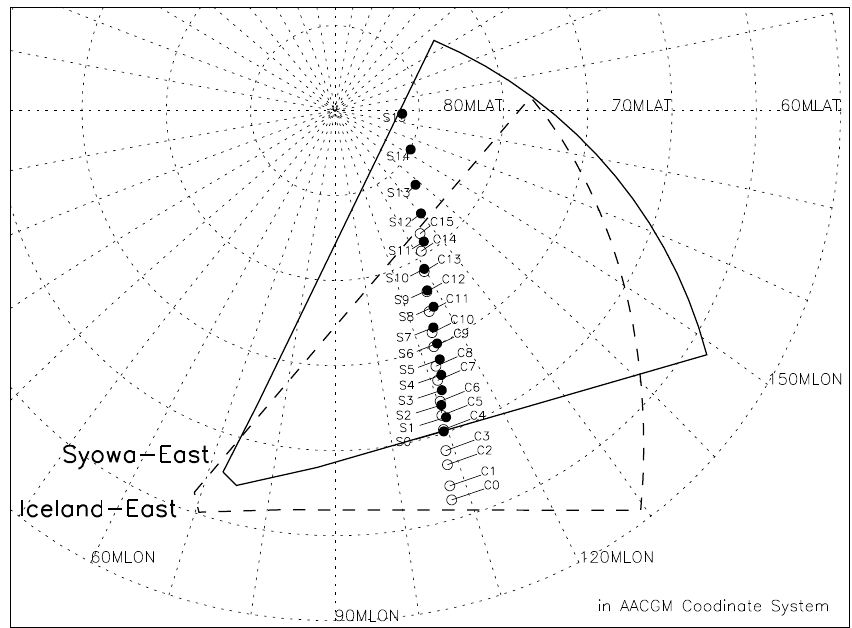
Fig. 1. The location of the summary point arrays within the field-of-view of CUTLASS Iceland-East and SENSU Syowa-East radars which are mapped into the AACGM coordinate system in the Northern Hemisphere. The solid fan-shaped area indicates the field-of-view of Syowa- East and dashed indicates that of Iceland-East. The summary points and the field-of-view of Syowa-East radar are mapped into the Northern Hemisphere using the IGRF95 model. Open circles indicate the summary points of Iceland-East from C0 to C15 and filled circles indicate those of Syowa-East from S0 to